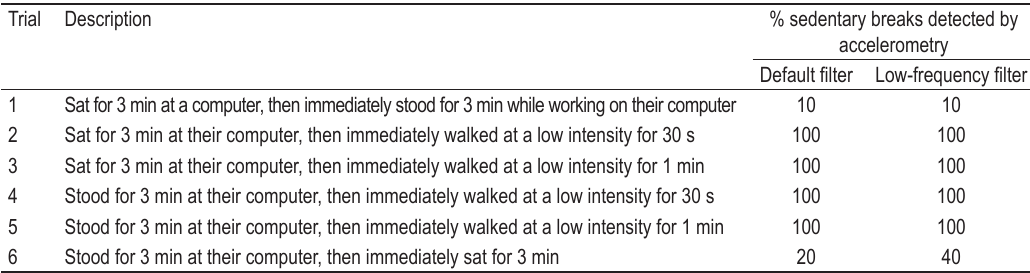
TABLE 2. The proportion of sedentary breaks detected by accelerometry during the transitional trials Trial